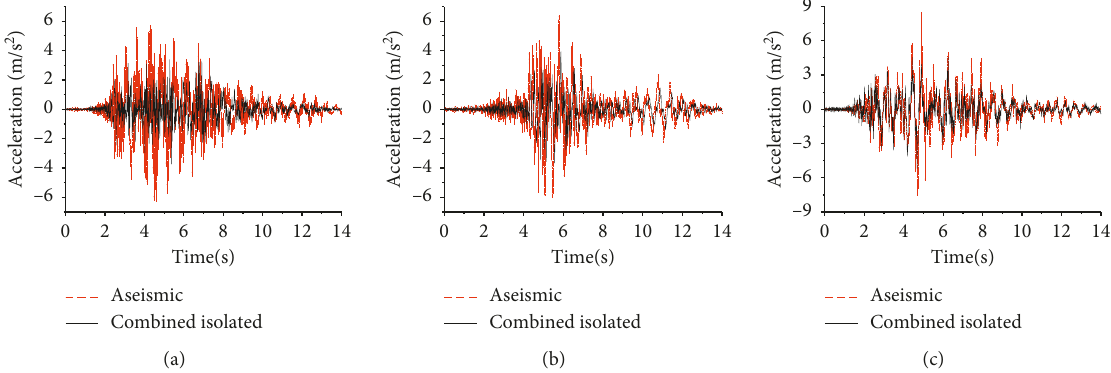
Figure 8: Y -axis acceleration time history curves of the third floor of main frame. (a) Chi-Chi-2N, (b) Chi-Chi-2F, and (c)